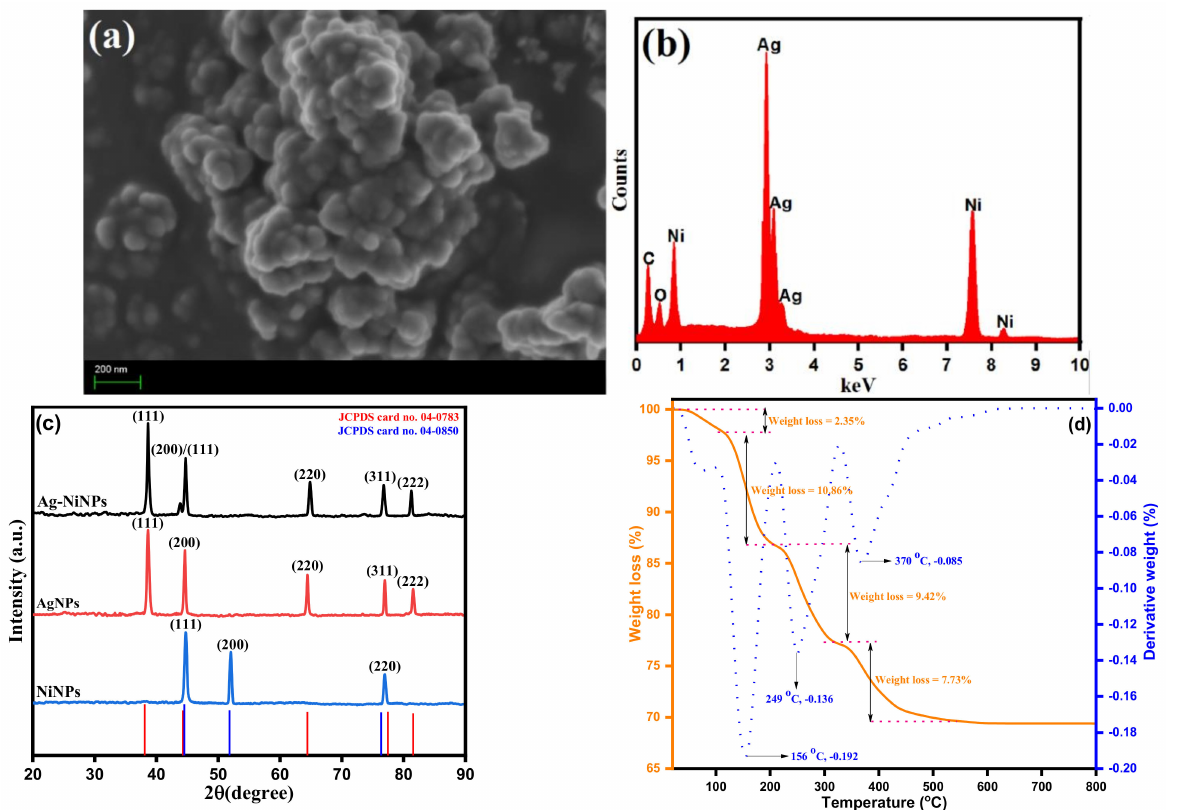
Figure 3. ( a ) Scanning electron microscopy (SEM) image, ( b ) energy-dispersive X-ray spectroscopy (EDX), ( c ) X-ray diffraction (XRD) patterns and ( d ) thermal gravimetric analysis-differential thermal analysis (TGA-DTA) curves of bimetallic Ag-Ni